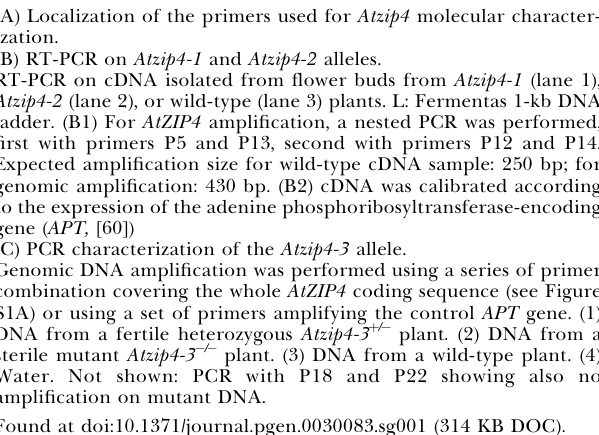
Figure S1. Molecular Characterization of the Atzip4 Alleles (A) Localization of the primers used for Atzip4 molecular character- ization. (B) RT-PCR on Atzip4-1 and Atzip4-2 alleles. RT-PCR on cDNA isolated from flower buds from Atzip4-1 (lane 1), Atzip4-2 (lane 2), or wild-type (lane 3) plants. L: Fermentas 1-kb DNA ladder. (B1) For AtZIP4 amplification, a nested PCR was performed, first with primers P5 and P13, second with primers P12 and P14. Expected amplification size for wild-type cDNA sample: 250 bp; for genomic amplification: 430 bp. (B2) cDNA was calibrated according to the expression of the adenine phosphoribosyltransferase-encoding gene ( APT, [60]) (C) PCR characterization of the Atzip4-3 allele. Genomic DNA amplification was performed using a series of primer combination covering the whole AtZIP4 coding sequence (see Figure S1A) or using a set of primers amplifying the control APT gene. (1) DNA from a fertile heterozygous Atzip4-3 þ / (cid:2) plant . (2) DNA from a sterile mutant Atzip4-3 (cid:2) / (cid:2) plant. (3) DNA from a wild-type plant. (4) Water. Not shown: PCR with P18 and P22 showing also no amplification on mutant DNA. Found at doi:10.1371/journal.pgen.0030083.sg001 (314 KB DOC). Figure S2. Single Color Images of Figure 6A–6L Coimmunolocalization of ASY1 (red) and ZYP1 (green) in wild-type PMCs. Prophase I cells showing increasing level of synapsis (according to anti-ZYP1 labeling) are shown: absence of synapsis (leptotene, A), partial synapsis (zygotene, B–J), and full synapsis (pachytene, K–L). For each cell, single labeling is shown as well as the merge signal. Bar, 10 l m. Found at doi:10.1371/journal.pgen.0030083.sg002 (2.2 MB TIF). Figure S3. Single Color Images of Figure 6M–6X Coimmunolocalization of ASY1 (red) and ZYP1 (green) in Atzip4-1 PMCs. Prophase I cells showing increasing level of synapsis (according to anti-ZYP1 labeling) are shown: absence of synapsis (leptotene, M), partial synapsis (zygotene, N–V), and full synapsis (pachytene, W–X). For each cell, single labeling is shown as well as the merge signal. Bar, 10 l